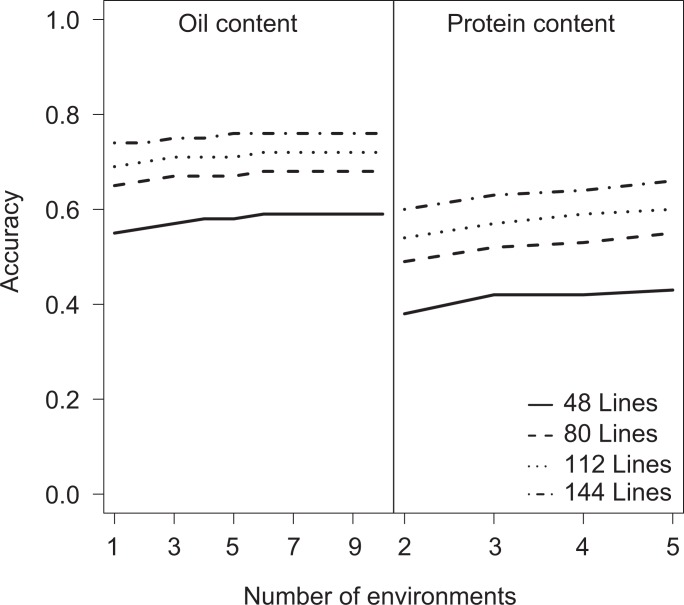
Prediction accuracy of oil content and protein content using marker data for 1,527 representative SNPs according to different numbers of environments and training set size.